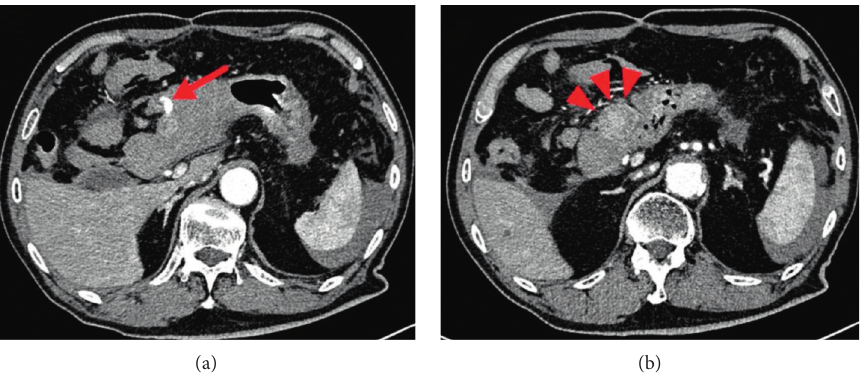
Figure 1: Contrast-enhanced abdominal computed tomography showed contrast leakage ((a), arrow) into the peritoneal cavity from a hypervascular mass ((b), arrowheads, 30 mm) on the gastric antrum’s anterior